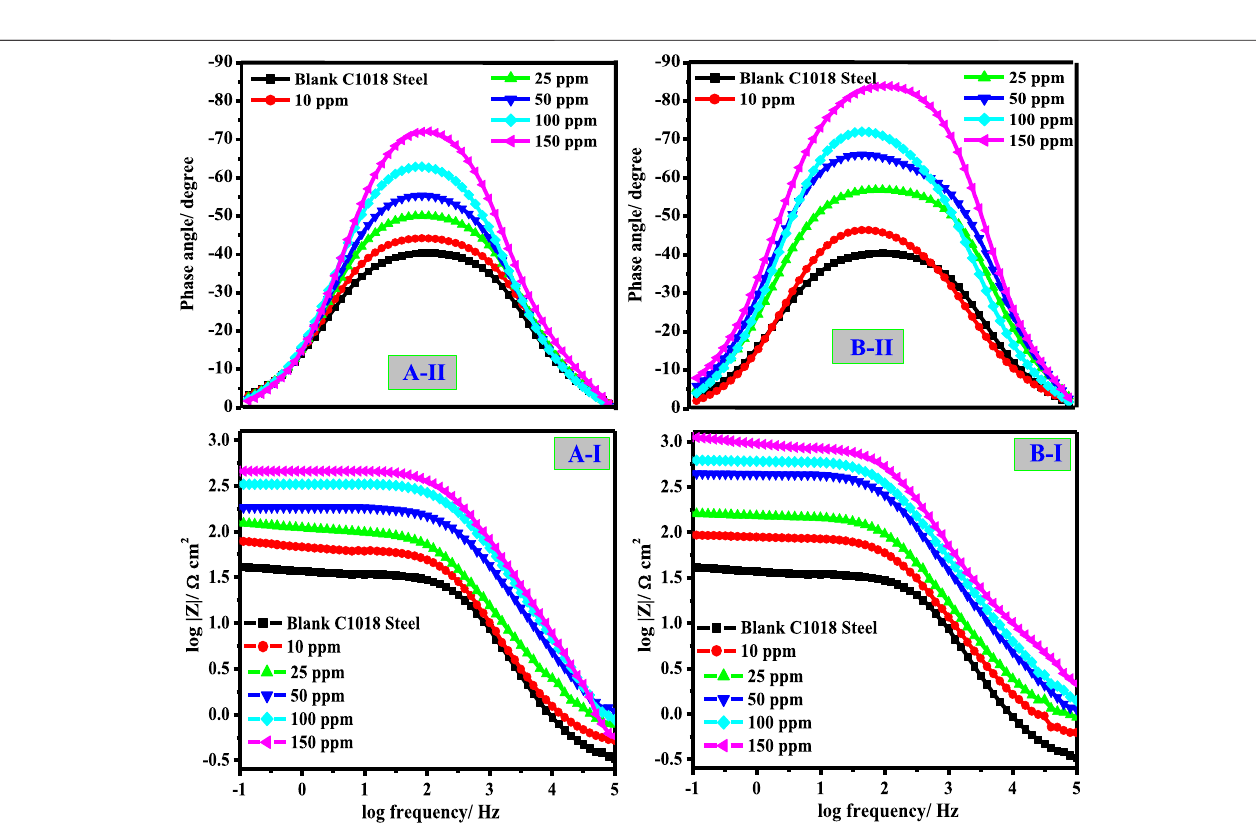
FIGURE 5 | Bode (I) and Bode phase (II) modules of C-steel/CO 2 -saturated 3.5% NaCl/surfactant uninhibited and inhibited by diverse concentration of (A) CSM and (B) CSD at 50 ± 1 ° C.